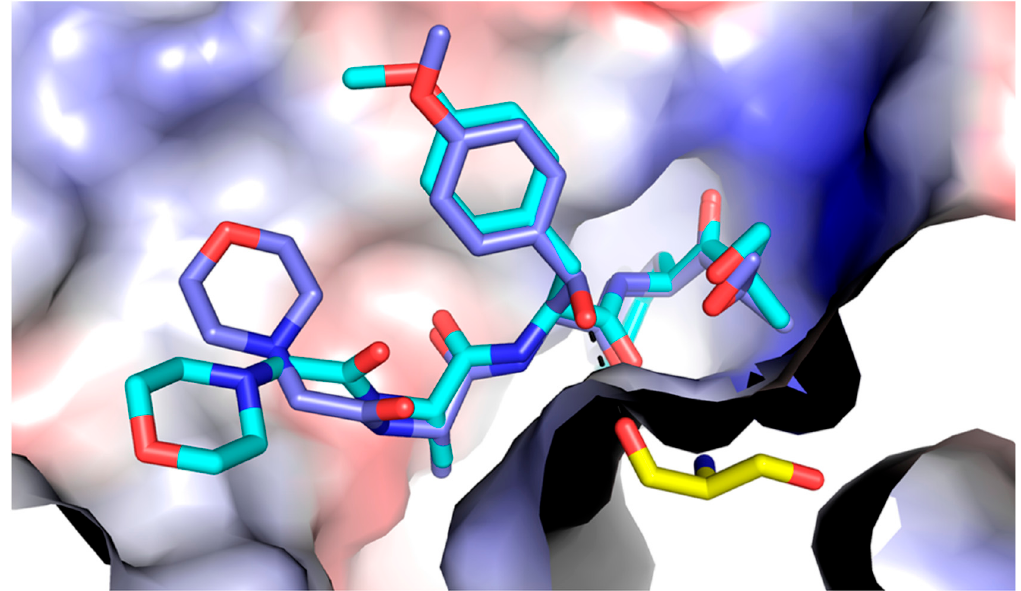
Figure 2. Binding modes of KZR-616 (purple) and ONX 0914 (blue) in the LMP7/ β 6 binding site of the human immunoproteasome. Adapted from [40].